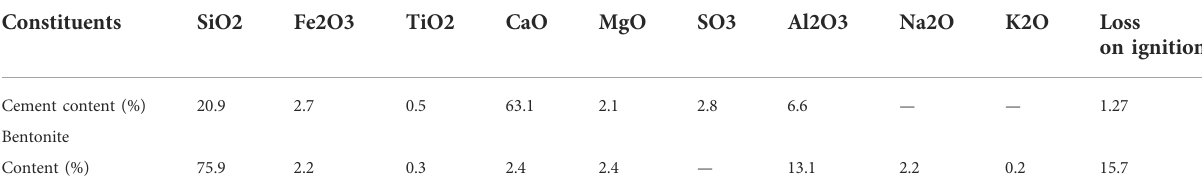
TABLE 1 The chemical constituents of the Portland cement and bentonite. Constituents